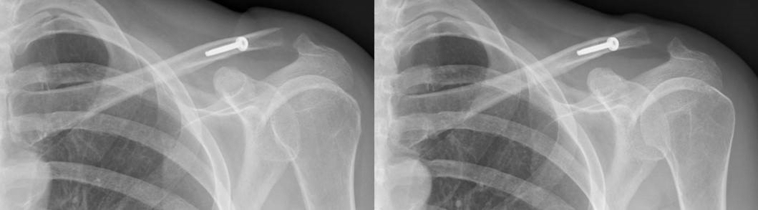
Radiographs at 6 weeks (left) and 3 months (right).